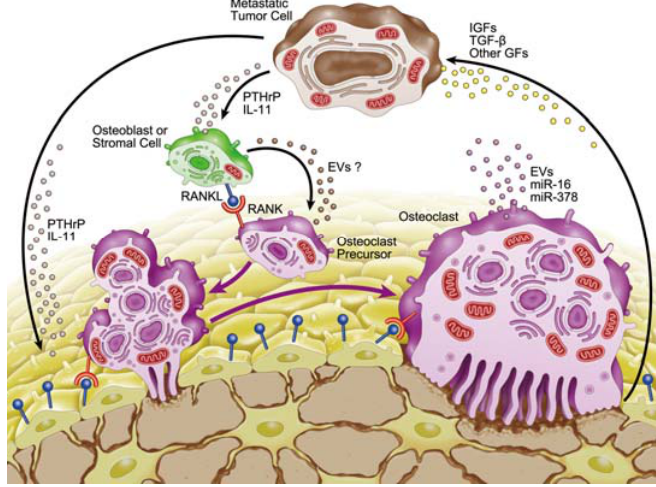
Figure 2. Schematic view of tumor-induced osteoclast formation. Bone-derived growth factors (IGFs, TGF- β and other growth factors) are released by osteoclastic